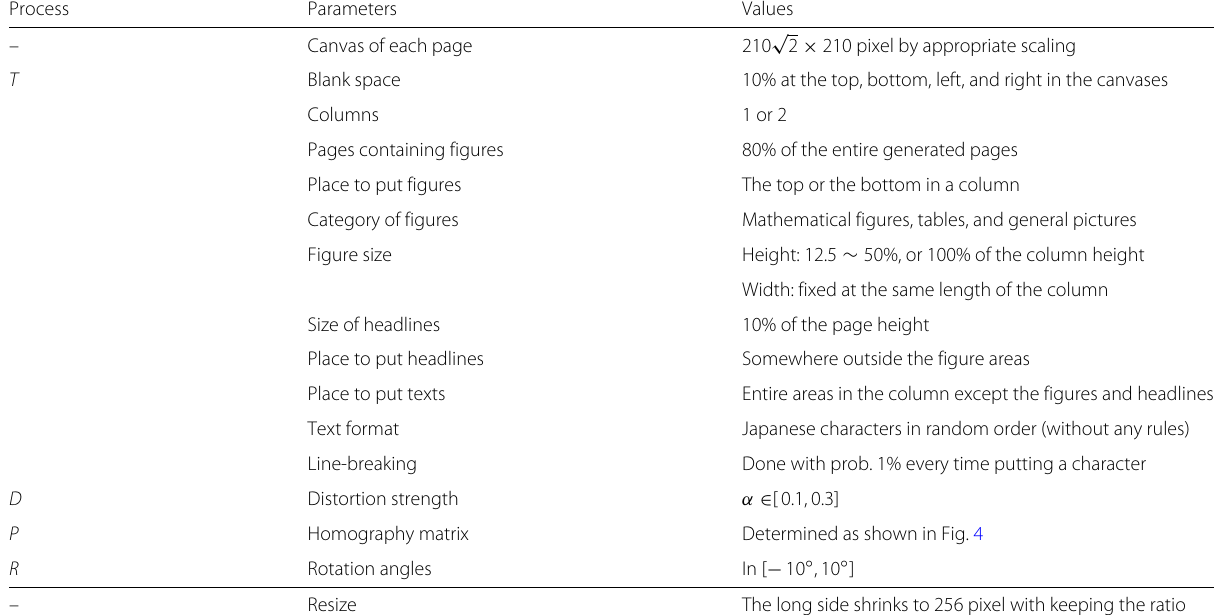
Table 1 Main parameters in the generation processes